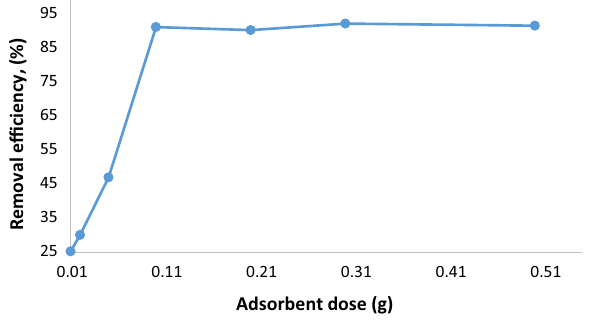
Fig. 5 Effect of pH on As(III) removal at different initial pH values